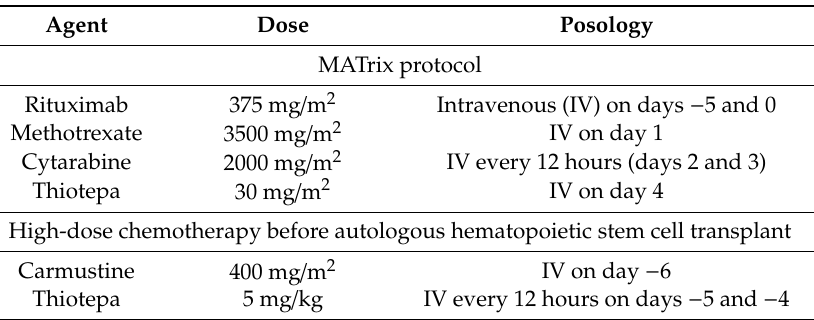
Figure 4. Immunohistochemical labelling with an antibody directed against CD20. The majority of the cells labelled are large neoplastic lymphoid cells. Table 1. Chemotherapy regimen given to the